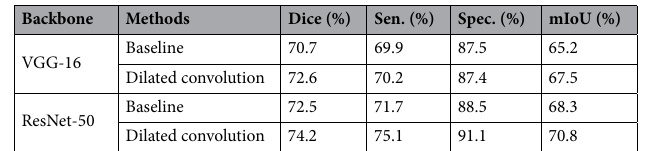
Table 1. Comparison of networks containing regular convolution and dilated convolution based on different backbones.